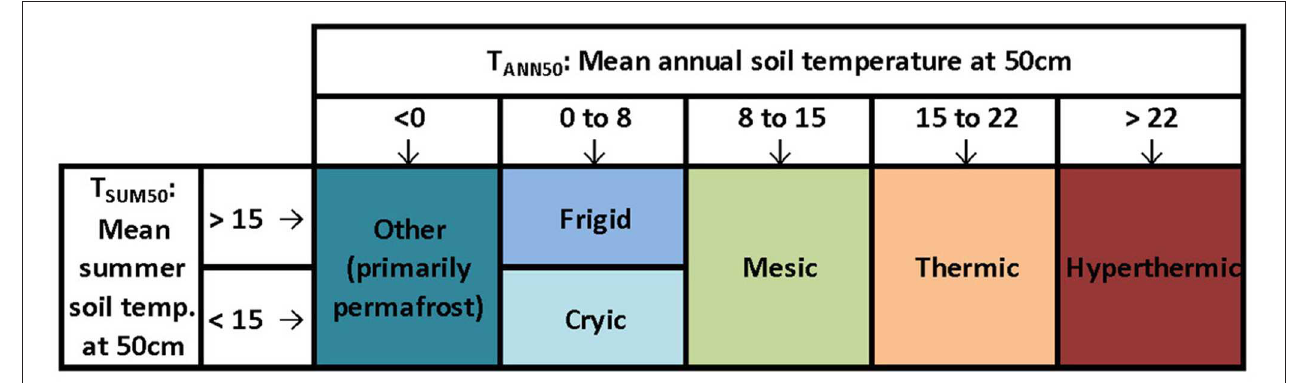
FIGURE 1 | Simplified relationships between soil temperature regimes (colors) and primary criteria for distinguishing the regimes. See text for descriptions of criteria.